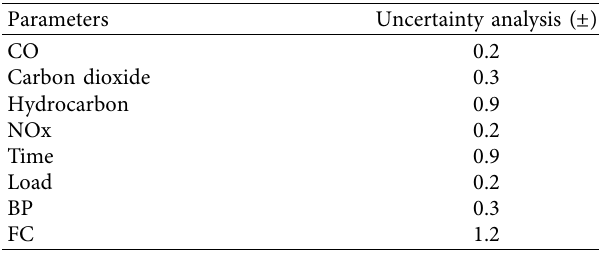
Table 6: Uncertainty analysis.